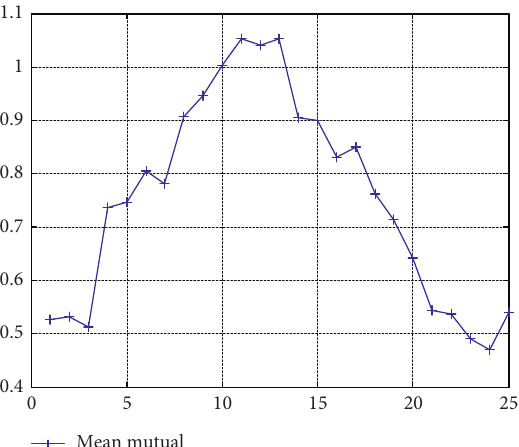
Figure 5: The mean mutual information among the 10 sector indexes in sliding window (the number on horizontal axis is the position of the window, and the number on vertical axis is the value of mean mutual).